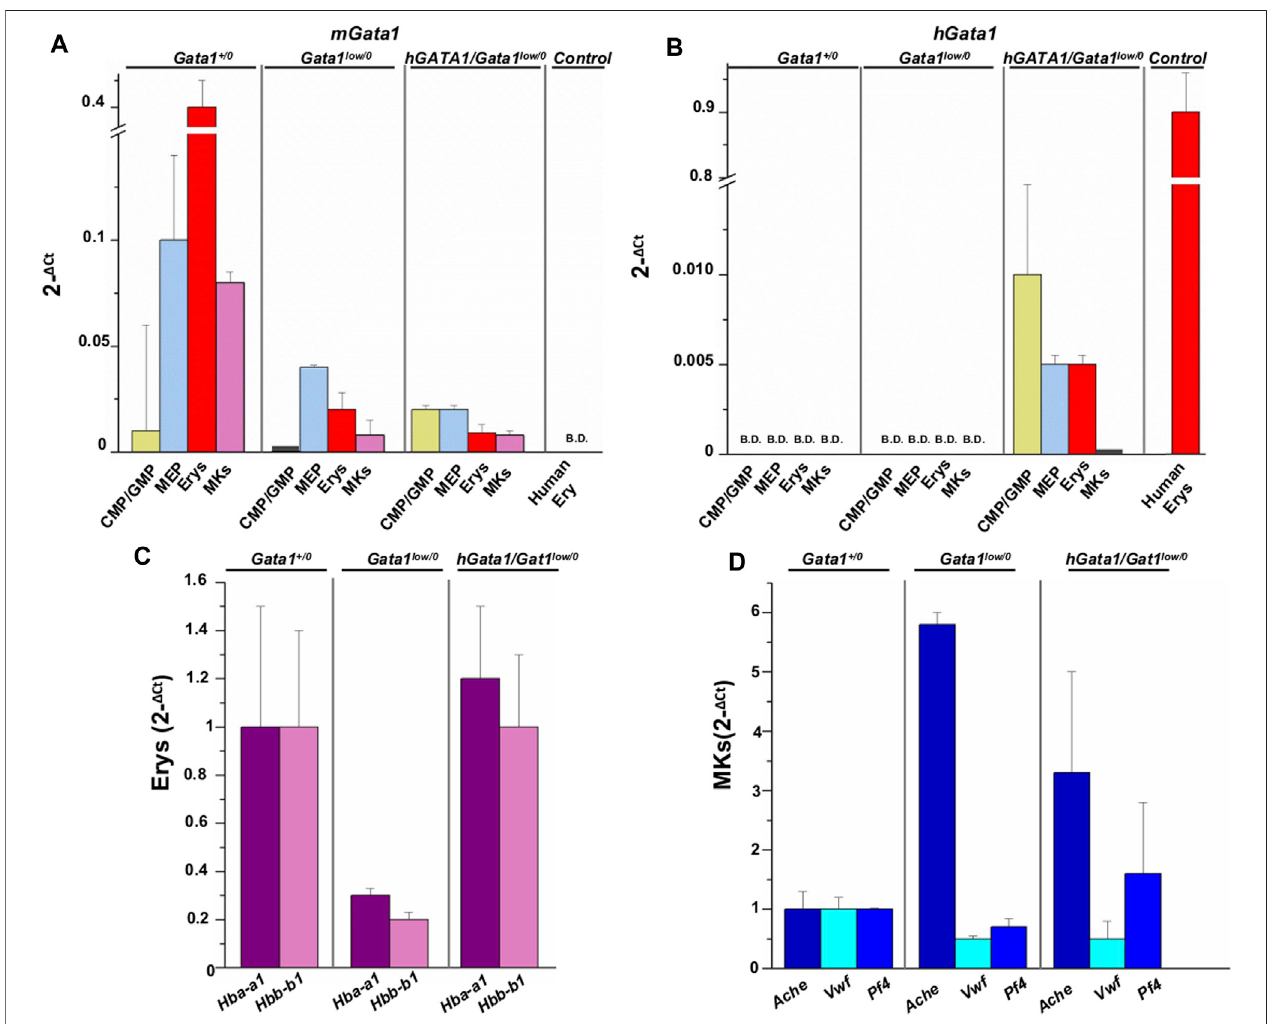
FIGURE 3 | hGATA1 is expressed in erythroid but not in megakaryocyte precursors prospectively isolated from hGATA1/Gata1 +/0 mice . Quantitative RT-PCR expression analysis of murine Gata1 ( mGata1 ) (A) and hGATA1 (B) mRNA in precursor and progenitor cells prospectively isolated from Gata1 +/0 , Gata1 low/0 and hGATA1 / Gata1 low/0 mice according tothephenotypes: CD117 pos /CD34 pos (CMP/GMP),CD117 pos /CD34 neg (MEP),TER119 pos /CD71 pos (Erys) and CD41 pos /CD61 pos (MKs. The levels of the erythroid speci fi c genes Hba-a1 and Hbb-b1 ( α - and β -globin) and of the megakaryocyte speci fi c genes Ache, Vwf and Pf4 (acetylcholinesterase, Von Willebrand factor and platelet factor 4) expressed by the Erys and MKs of the four experimental groups are presented in (C,D) , respectively. Data are expressed as 2 − Δ Ct and are presented as Mean ( ± SD) of those obseved with cells independently isolated in 3 different experiments each with one mouse per group. Ex vivo expanded human erythroblasts (CD235a pos /CD36 pos cells) served as control for the expression of hGATA1. Statistical analyses were performed by One- way analysis of variance Tukey Multiple Comparison Test. Results of the statistical analyses: in (A,B) : CMP/GMP: Statistically non-signi fi cant; MEP: Gata1 +/0 vs. Gata1 low/0 p < 0.05; Gata1 +/0 vs. hGATA1/Gata1 low /0 p < 0.01; Erys: Statistically non-signi fi cant; MKs: Gata1 +/0 vs. Gata1 low/0 p < 0.001 and Gata1 +/0 vs. hGATA1/ Gata1l ow/0 p < 0.001. In (C,D) : Erys (cid:2) Hba-a1 : Gata1 low/0 vs. hGATA1/Gata1 low/0 p < 0.05; Hbb-b1 : Gata1 +/0 vs. Gata1 low/0 and Gata1 low/0 vs. hGATA1/Gata1 low/0 p < 0.05; MKs (cid:2) Ache : Gata1 +/0 vs. Gata1 low/0 p < 0.01; Vwf : Gata1 +/0 vs. Gata1 low/0 p < 0.01; Gata1 +/0 vs. hGATA1/Gata1 low/0 p <